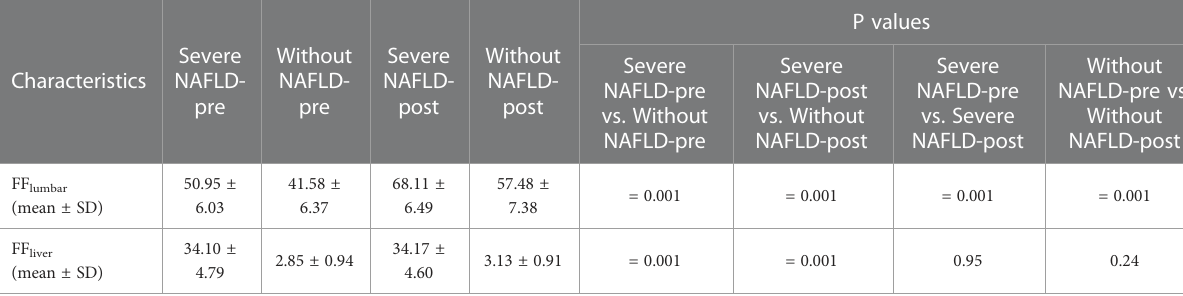
TABLE 3 The fat fraction values of the lumbar vertebra and liver in the fi rst cohort. Characteristics